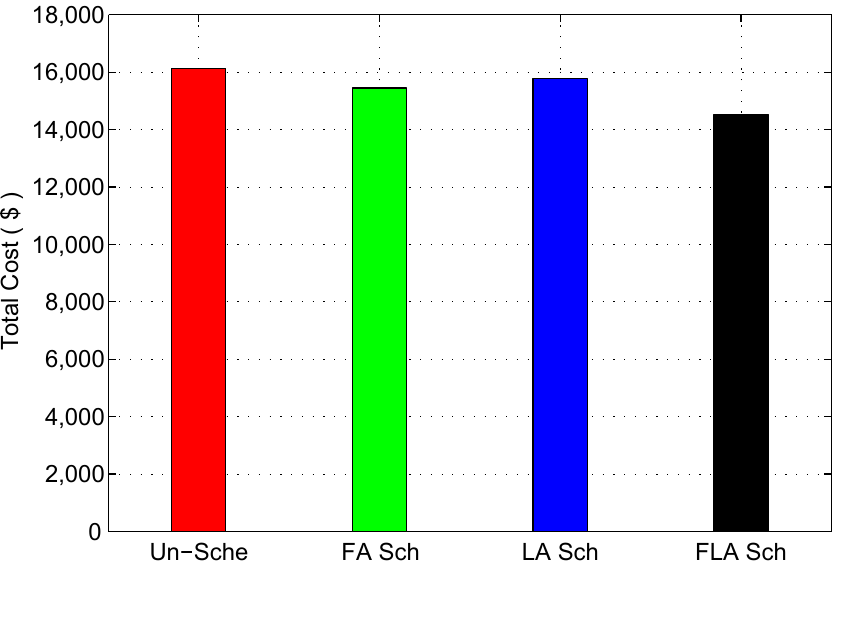
Figure 7. Total energy cost.